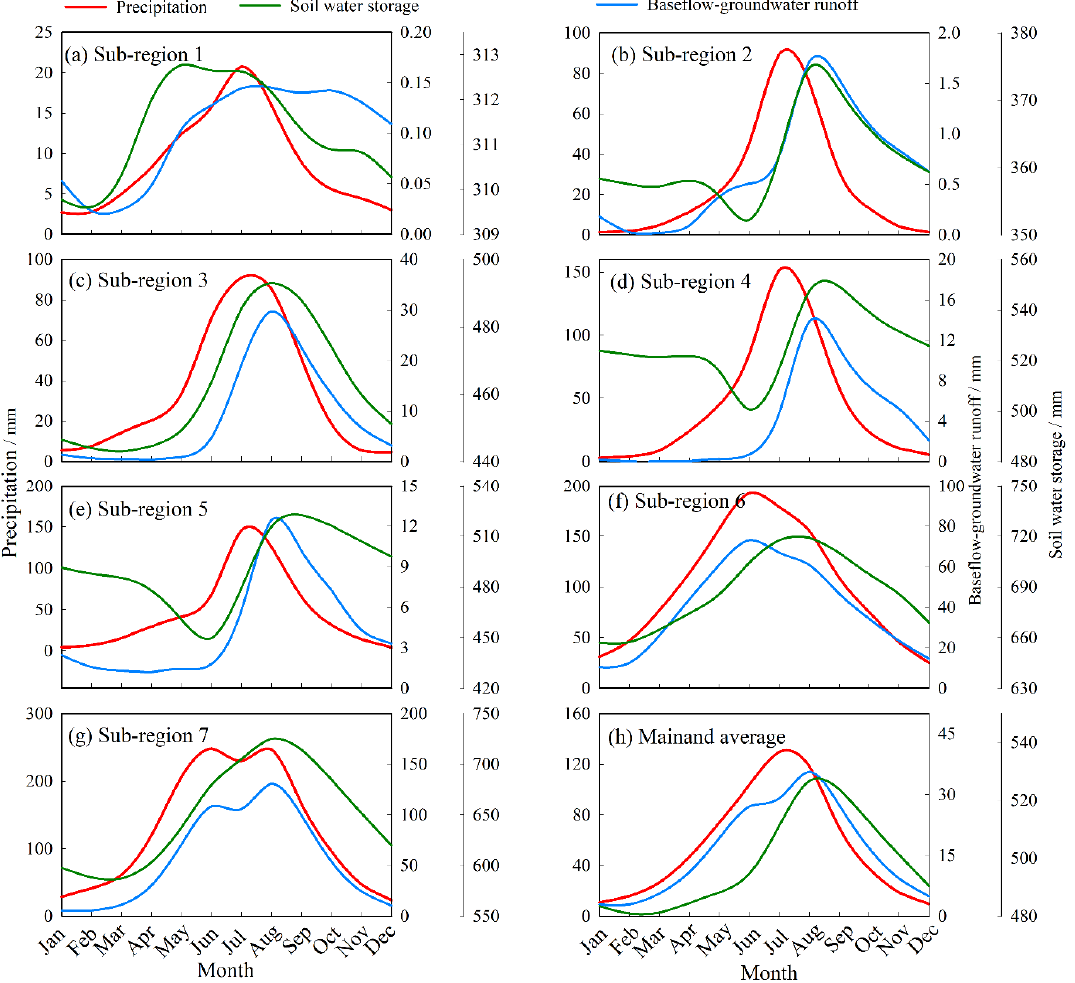
Figure 5. The annual mean (1948–2010) monthly variations of precipitation, soil water storage, and baseflow-groundwater runoff in different sub-regions and mainland China.